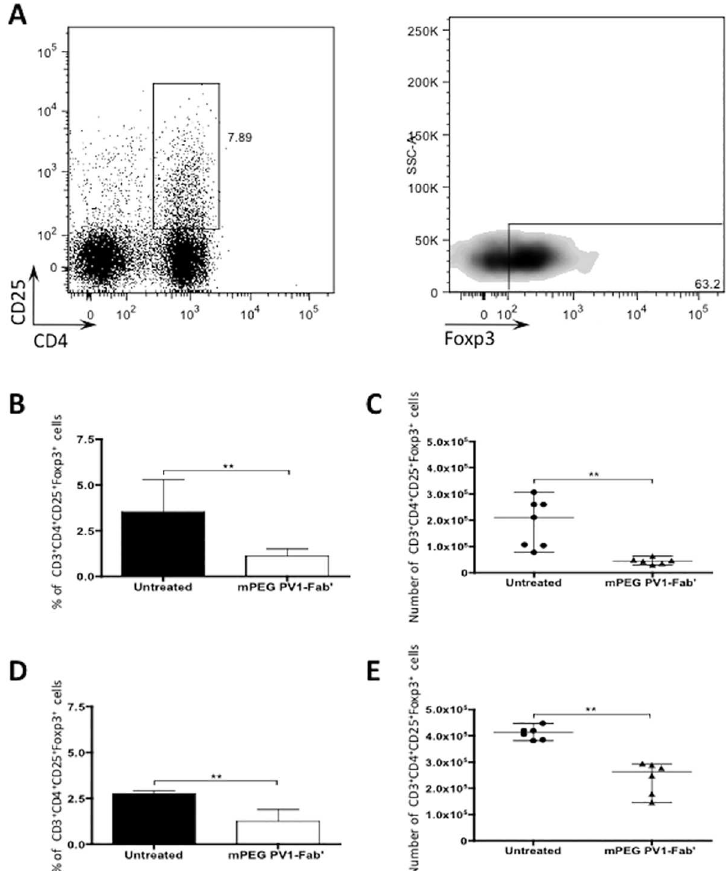
Fig 4. mPEG PV1-Fab’ treatment decreasesT reg population. Female B10.RIII mice were immunizedwith 50 μ g/animalof 161–180IRBP in CFA, plus 500 ng/animal of PTx boost. Starting on day 9, mice were treated every 4 days with CD28antagonist,PV1 (10mg/Kg; ip), or left untreated. On day 14 mice were sacrificedand dLN were collectedfor immunophenotypingof regulatoryT cells. (A) Representative plot showinggate strategy for definingT reg population.Foxp3 expressionwas definedby using a Fluorescence Minus One (FMO) control. (B) Frequency and (C) total number of CD3 + CD4 + CD25 + Foxp3 + cells in dLN of B10.RIII mice. (D) Frequency and (E) total numbers of CD3 + CD4 + CD25 + Foxp3 + cells in spleenof B10.RIII mice. Data are representative of three independent experiments; 5-mice per group. Median and range are depicted. ** , p < 0.01,two-tailedMann-Whitney